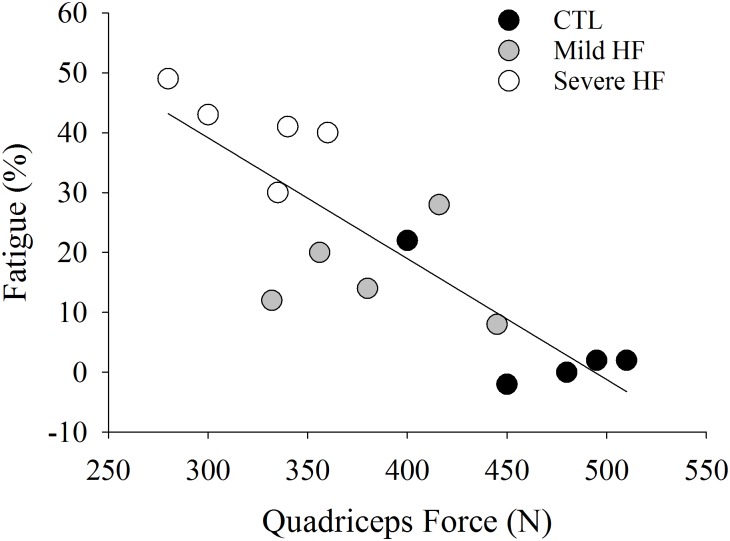
Data extracted from Buller et al. (1991). Quadriceps force was strongly associated with fatigue (%) (r = 0.81, P < 0.001). Individuals who were weaker (severe HF patients) had the greatest fatigability (%).